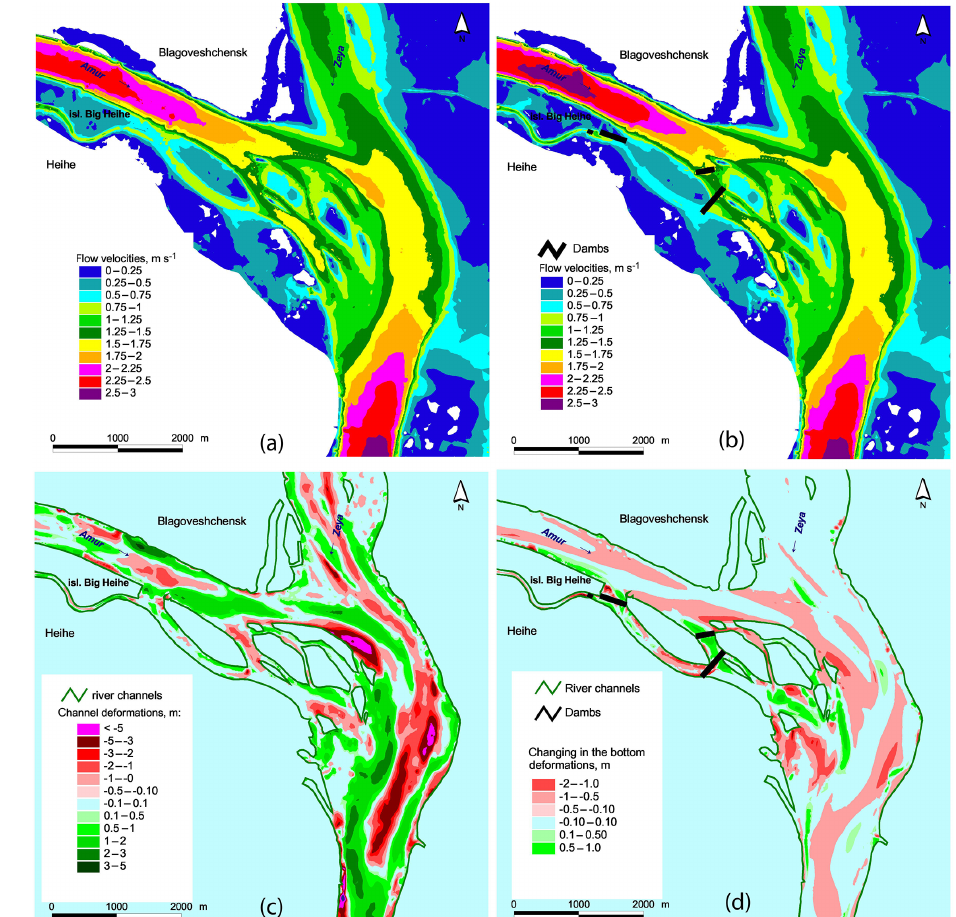
Figure 2. Modelled flow velosities during peak flow in the 2013 year according scenario 1 (a) and scenario 2 (b) ; modelled channel evolution at the confluence of the Amur and Zeya rivers for 5-year forecast period according scenario 1 (c) , changes in channel bottom changes due to construction of dams (difference in changes between scenarios 2 and 1) (d)